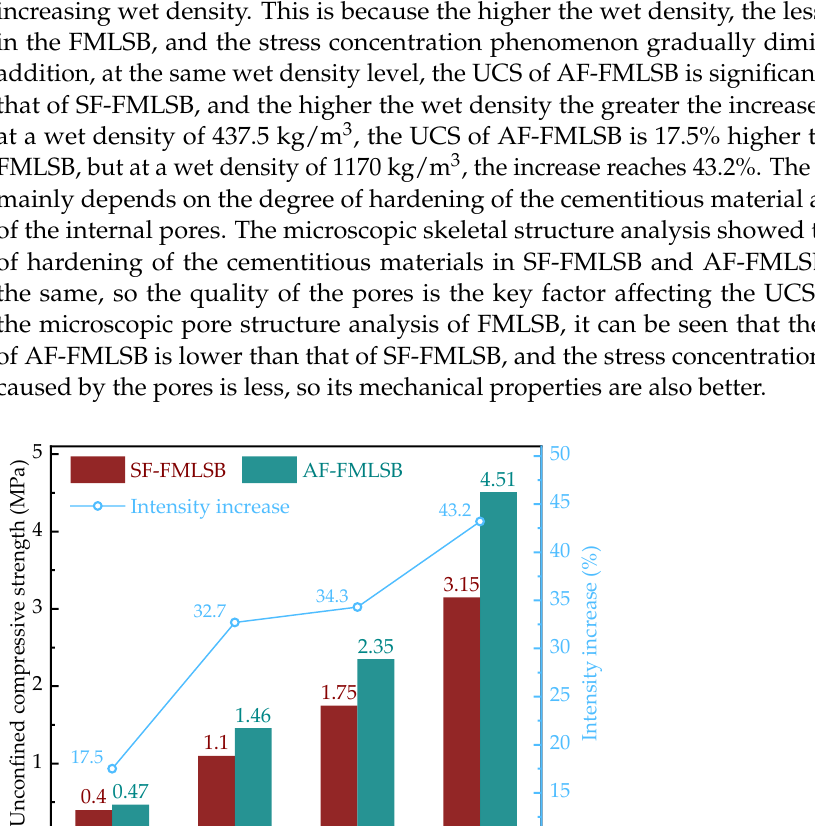
Figure 9. 28 d UCS of SF-FMLSB and AF-FMLSB. Fitting the data of area porosity and UCS of SF-FMLSB and AF-FMLSB, a plot of area porosity versus unconfined compressive strength can be obtained, as shown in Figure 10. It can be seen that the 28 d UCS of FMLSB decreases in an exponential trend as the area